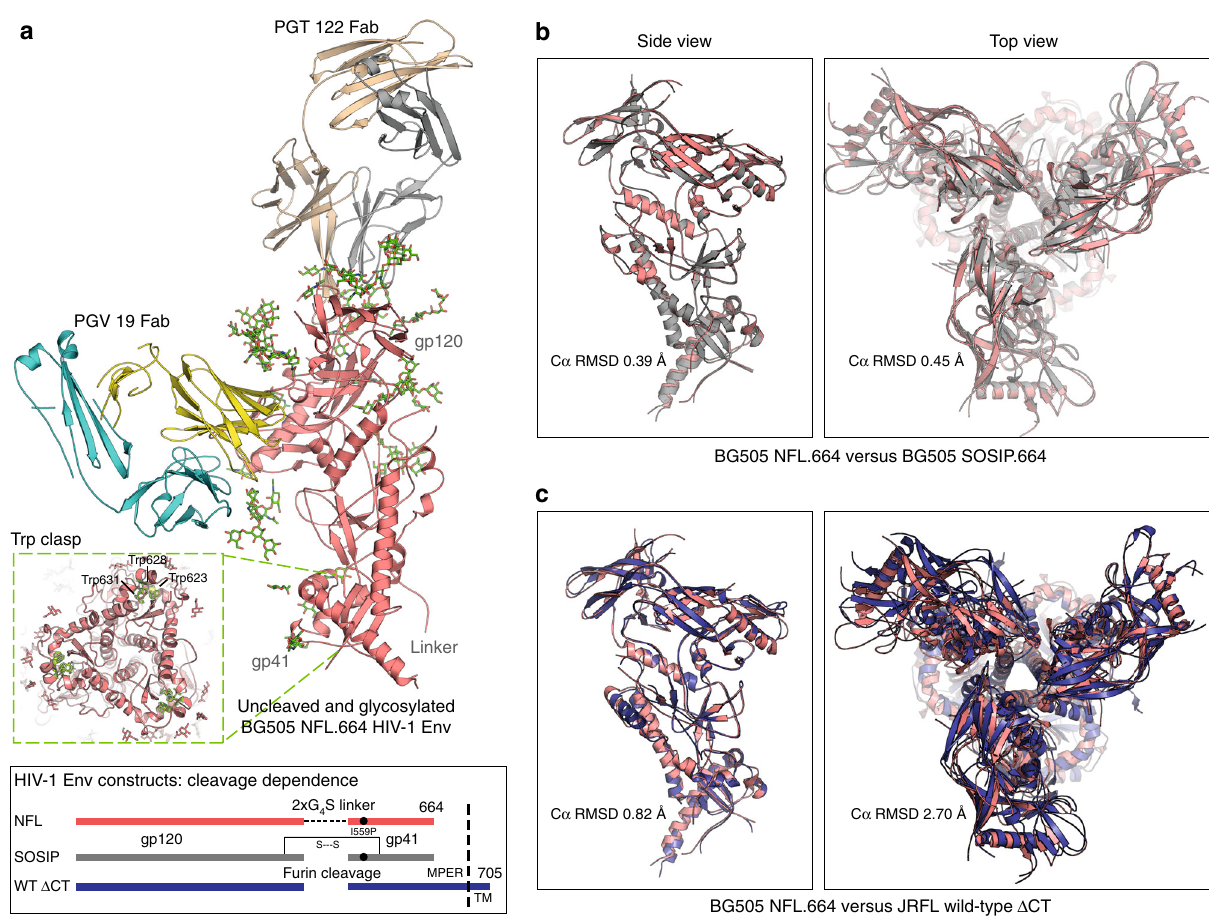
Fig. 1 Molecular architecture and comparison of the soluble, cleavage-independent BG505 NFL.664 with natively cleaved designs. a The crystal asymmetric unit of the complex comprises one copy of the BG505 NFL.664 protomer (salmon) bound to one PGT122 Fab (LC: gray, HC: wheat) at the N332 site and PGV19 (LC: cyan, HC: yellow) at the CD4bs. Inset: The gp41 tryptophan clasps (green) are still present on the vertices of the NFL trimer ’ s lower aperture. The bottom panel schematic illustrates the cleavage dependence and design variations between different trimeric Env constructs 16, 20,37 . b Comparison of the crystal structures of BG505 NFL.664 and BG505 SOSIP (PDB 5CEZ, gray) (side view of protomer and top view of trimer). c Comparison of the crystal structure of BG505 NFL.664 and the cryo-EM structure of JRFL WT Δ CT (PDB 5FUU, dark blue) (side view of protomer and top view of trimer). The large RMSD between the compared trimer structures arises from the asymmetry in the JRFL WT Δ CT induced by binding of two PGT151 antibodies per